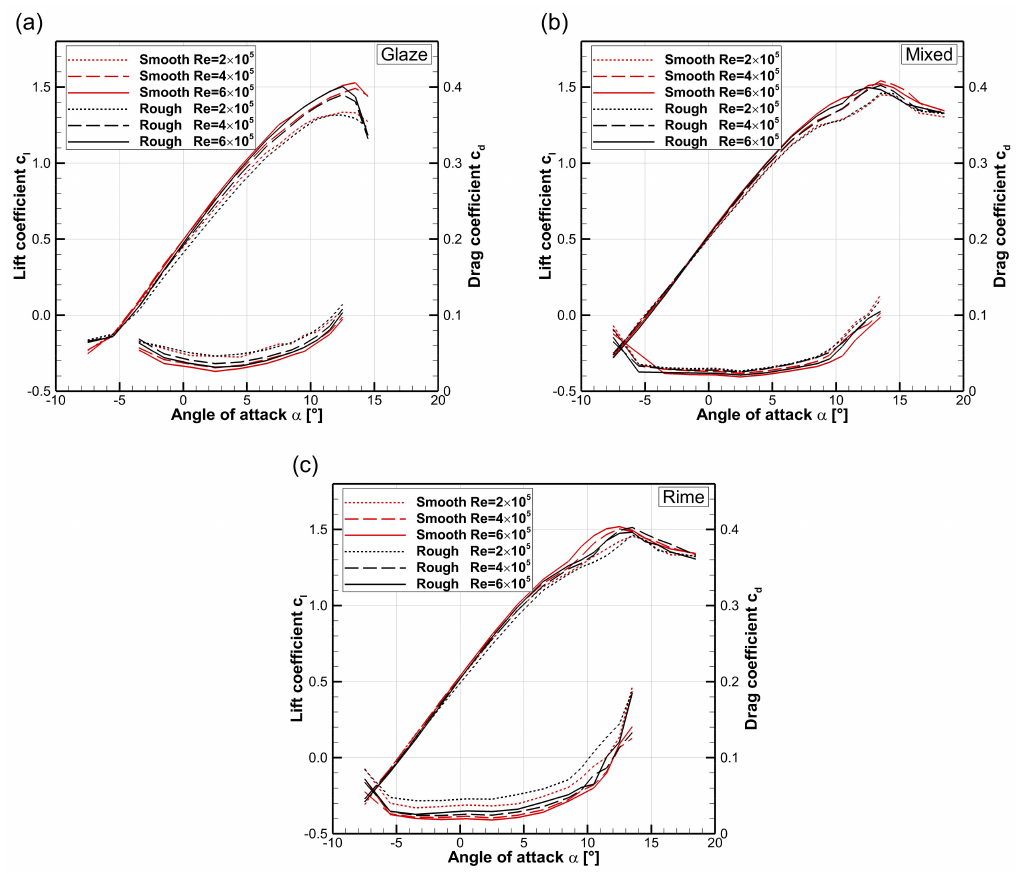
Figure 8. Comparison of experimental results for lift and drag between the smooth and rough IWT ice shapes for glaze ( a ), mixed ( b ), and rime ( c